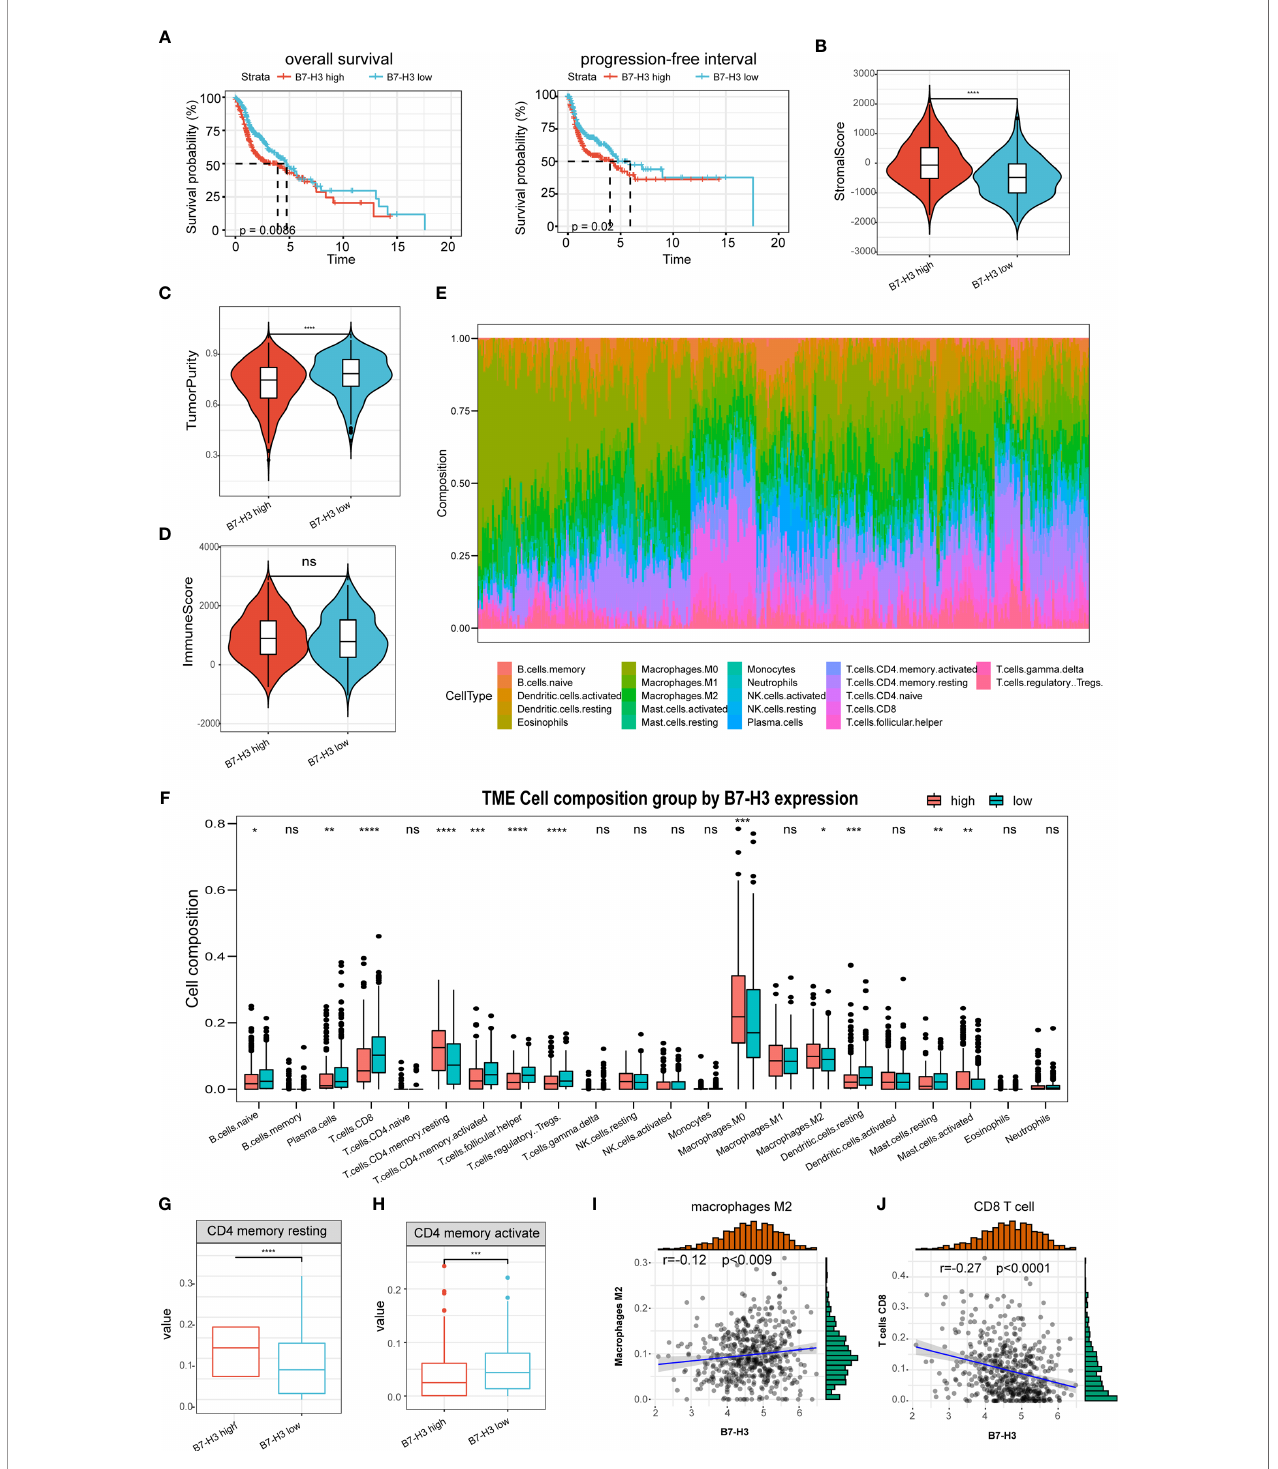
FIGURE 2 | The association of B7-H3 with tumor microenvironment and prognosis. (A) Kaplan – Meier plots show the prognostic signi fi cance of B7-H3 in HNSCC; (B – D) Violin plots present the differential stromal score (B) , tumor purity (C) , and immune score (D) between B7-H3 low-and high-groups; (E) Relative proportion of immune in fi ltration in HNSCC patients; (F) box plot shows the differential immune in fi ltration between B7-H3 low- and high-groups; (G, H) Box plots visualize considerably different CD4 memory resting cells (G) and CD4 memory active cells between B7-H3 low-and high-groups; (I, J) Scatter plots show the relationship of B7-H3 expression with macrophage M2 cells (I) and CD8 T cells (J) ; *P < 0.05, **P < 0.01, ***P < 0.001, & ****P < 0.0001. NS, P ≥